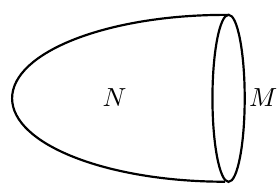
Figure 2 . M is the worldvolume of a magnetic brane, and we take a manifold N whose boundary is M